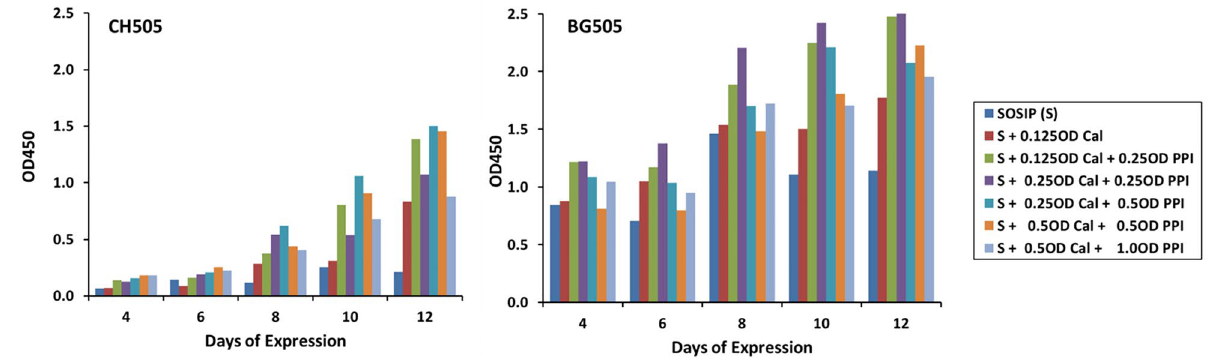
Figure 5. Phenotypic screening for leaf toxicity following infiltration of CH505 and BG505 SOSIP in the presence of PPI and PPI + CRT. CH505 (left) and BG505 (right) were infiltrated at OD600 = 0.35. In the absence of chaperones, the ELISA OD450 for CH505 is typically 0.1–0.3 and for the BG505